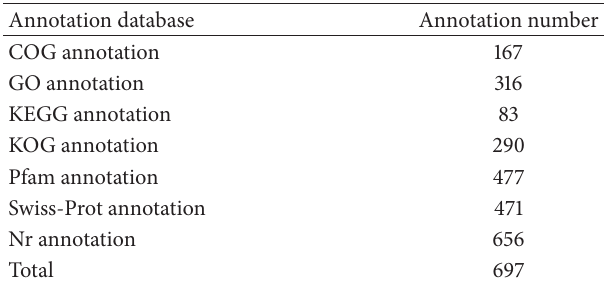
Table 2: Functional annotation of DEGs between Weiduoli and